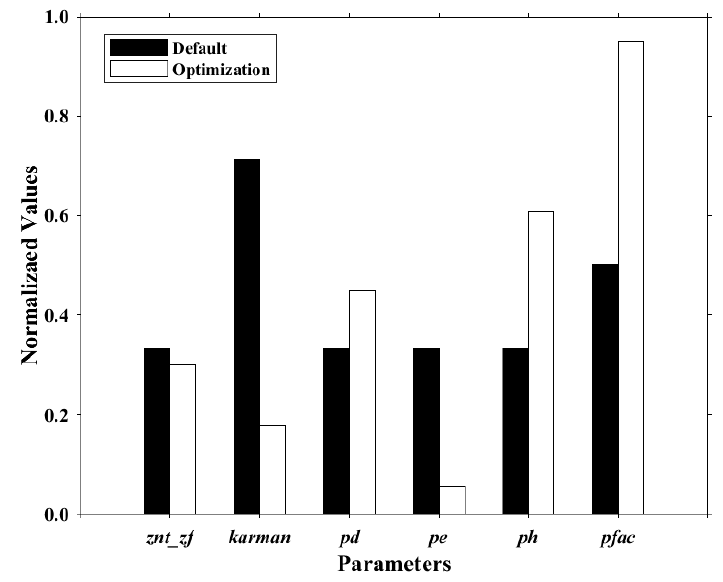
Figure 16. Comparisons of normalized optimal and default parameter values.